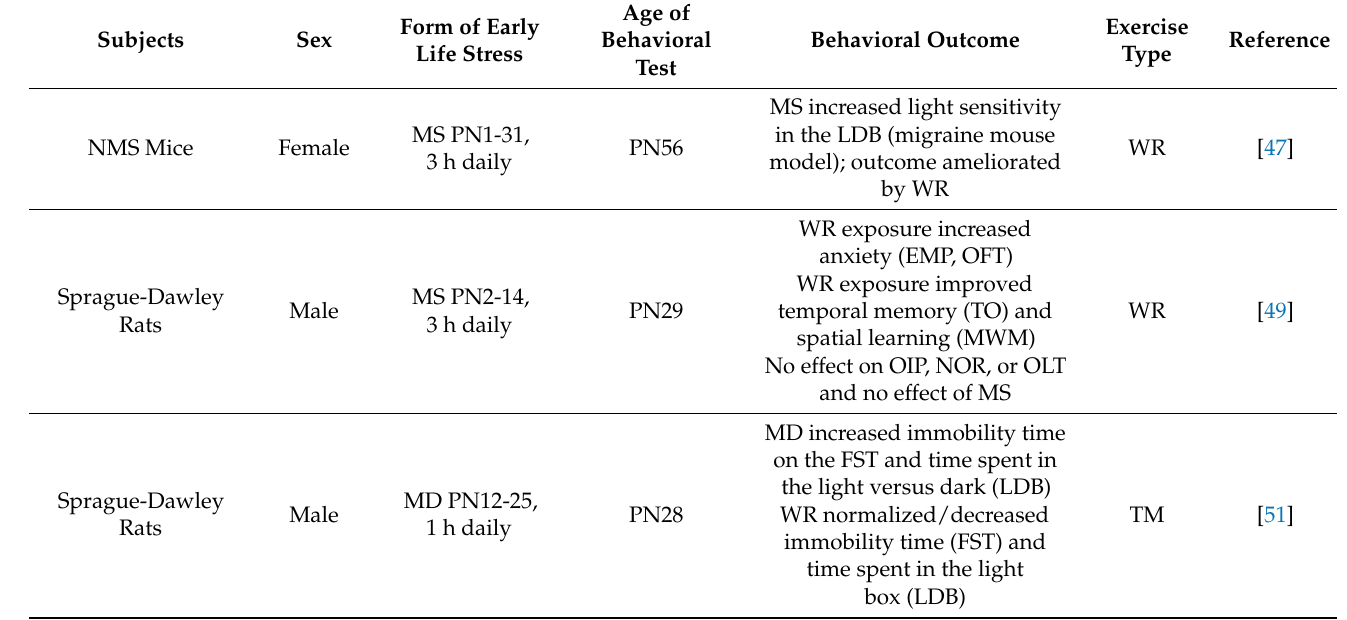
Table 2. Summary of Behavioral Findings in Currently Published ELS-Exercise Intervention